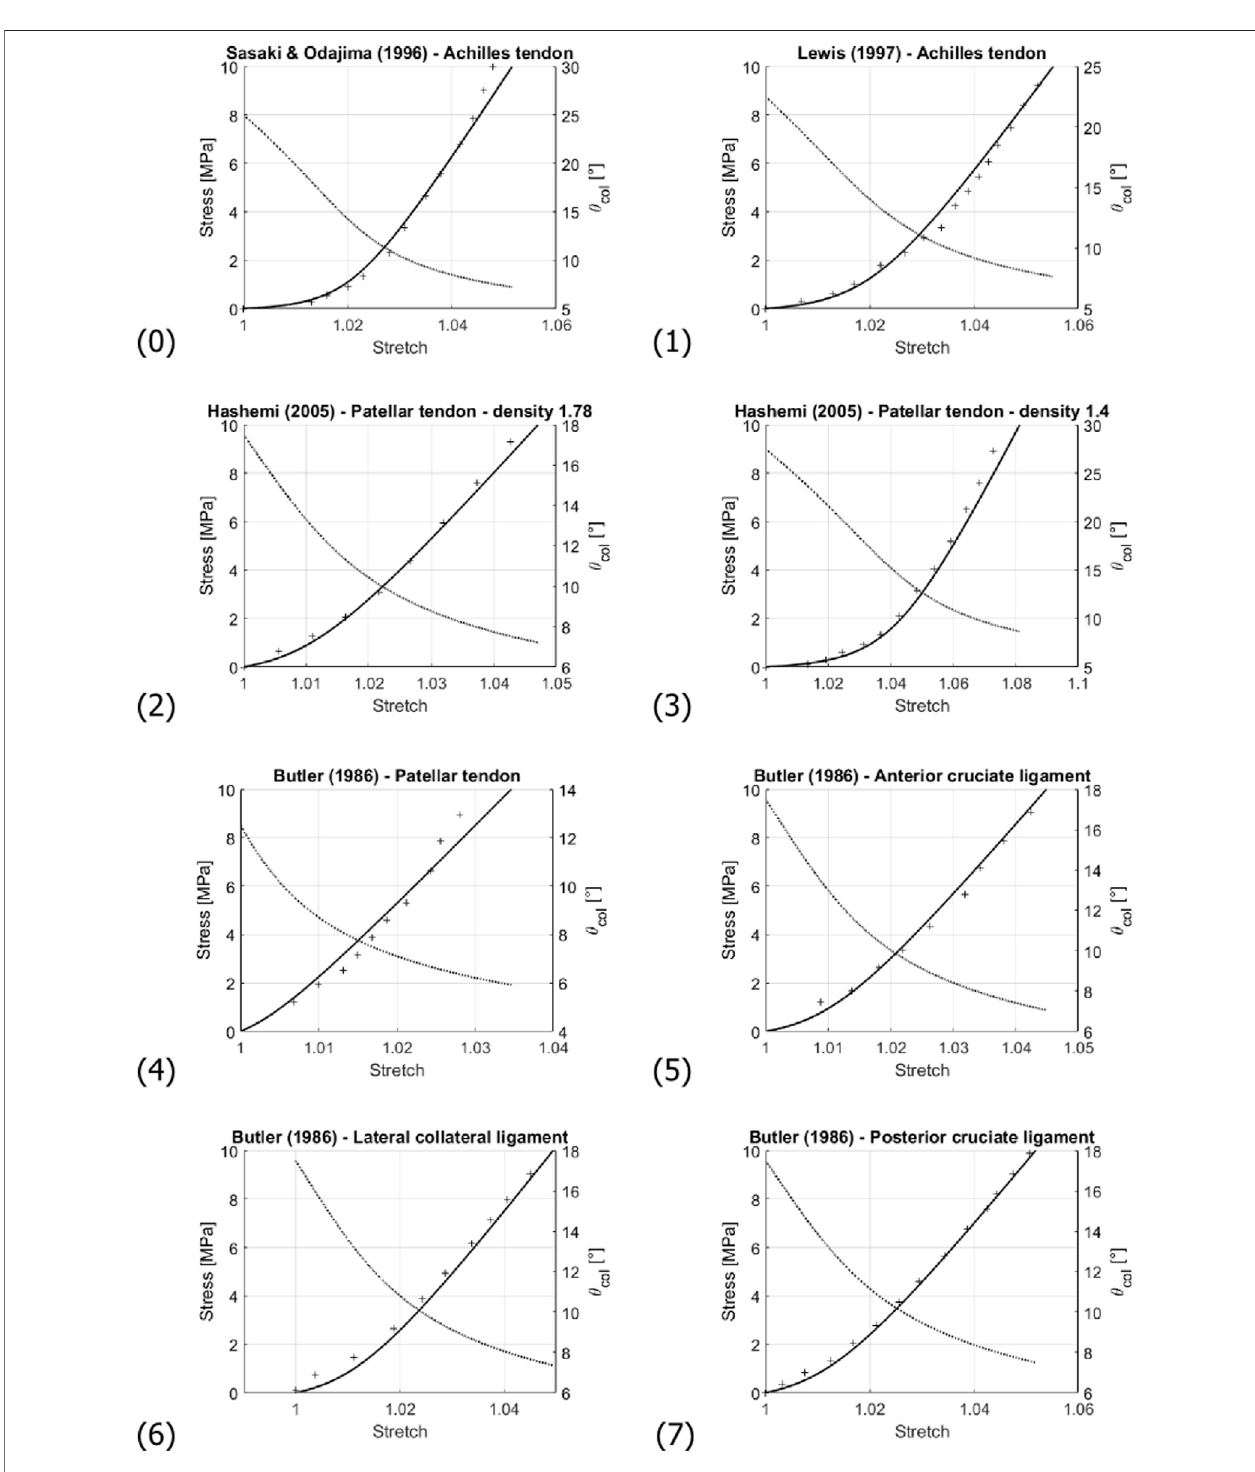
FIGURE7| Comparisonoftheexperimentally-measured(crosses)andpredicted(solidline)stress-stretchcurve;andevolutionofthecollagen fi brilinclinationangle θ fi gures refers to Table 3 . Note that stress and angle values are labelled at the left and right sides of the diagrams, respectively. col (dashed line). Numbering of the sub